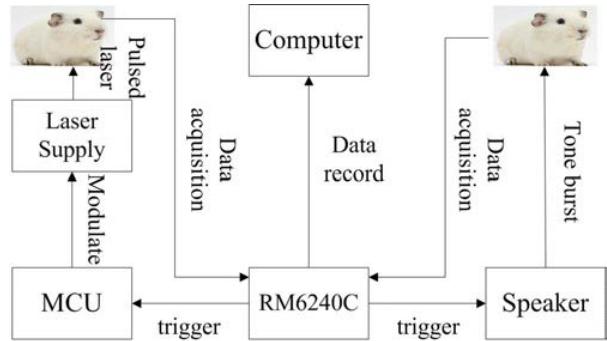
Fig. 1. A schematic diagram of the acoustic and infrared neuron stimulation. The pulse width was modulated by a microcontroller unit. The laser output was coupled into a 200 (cid:1) m-diameter optical ¯ber. The speaker is to give acoustic stimuli and the RM6240C is to acquire all the